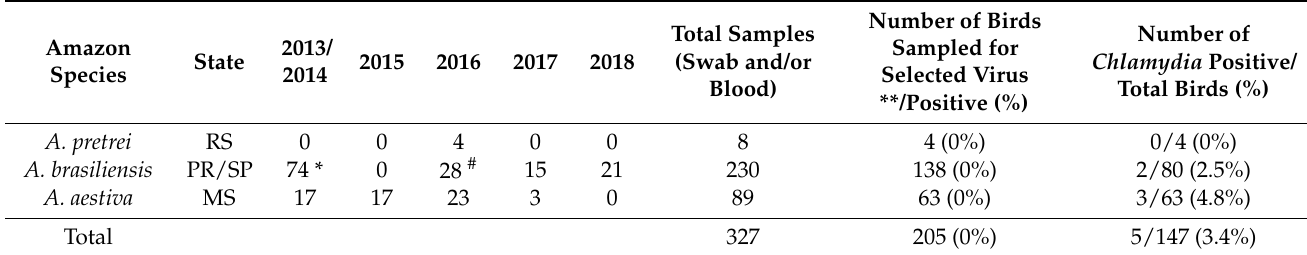
Table 1. Number of wild Amazon parrot nestlings sampled according to breeding season in the states of Rio Grande do Sul (RS), Paran á (PR), Mato Grosso do Sul (MS) and S ã o Paulo (SP),